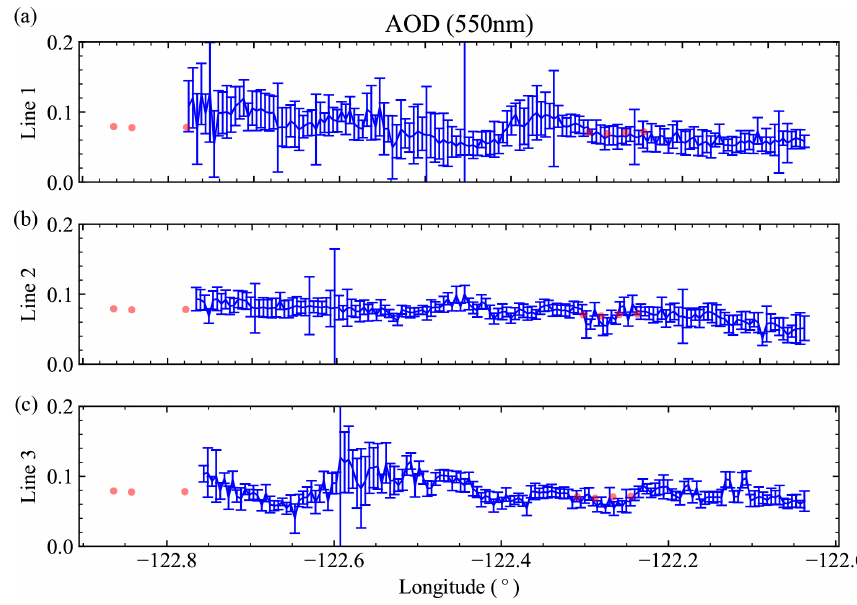
Figure 11. Retrieved AOD at 550nm and their uncertainties along the three lines shown in Fig. 10 from bottom to top. Red dots are the HSRL AOD at 550nm as indicated in Fig. 10.